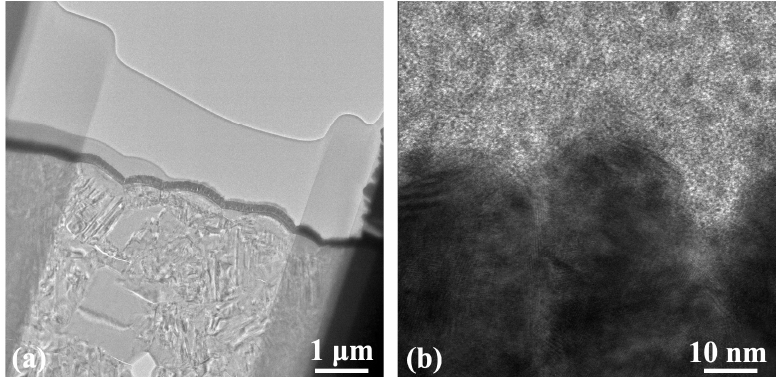
Figure 9. TEM images showing changes in the pore surface after thermal exposure, ( b ) is the detail figure of ( a ).